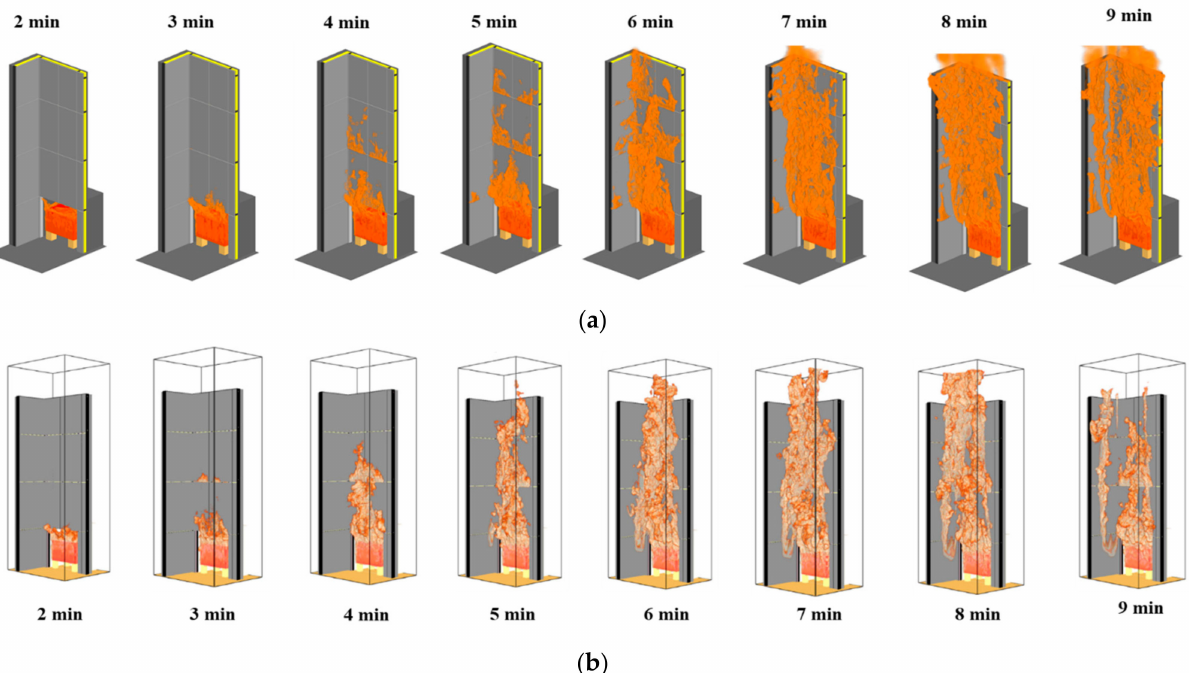
Figure 8. Visual observations of numerical simulation of full-scale cladding test. ( a ) Results obtained from the current FDS model. ( b ) Results obtained from the Drean et al. [22]